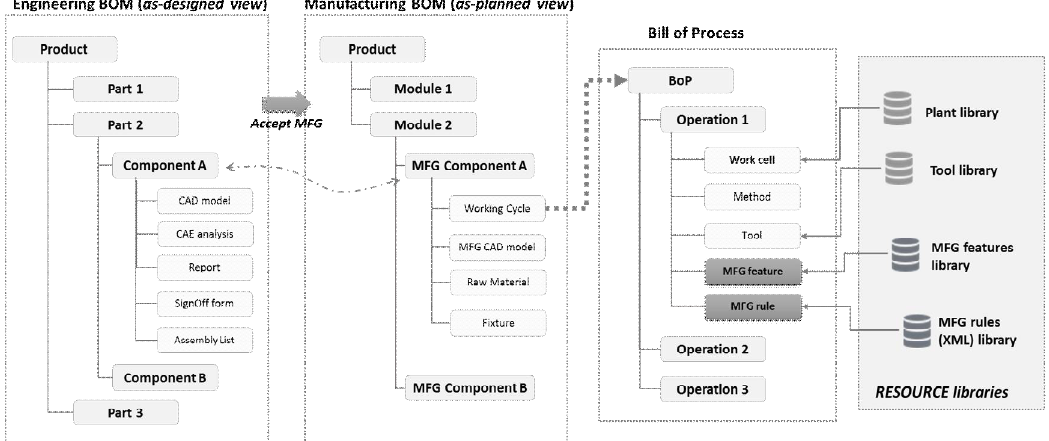
Figure 7. Product Lifecycle Management (PLM) data structure.